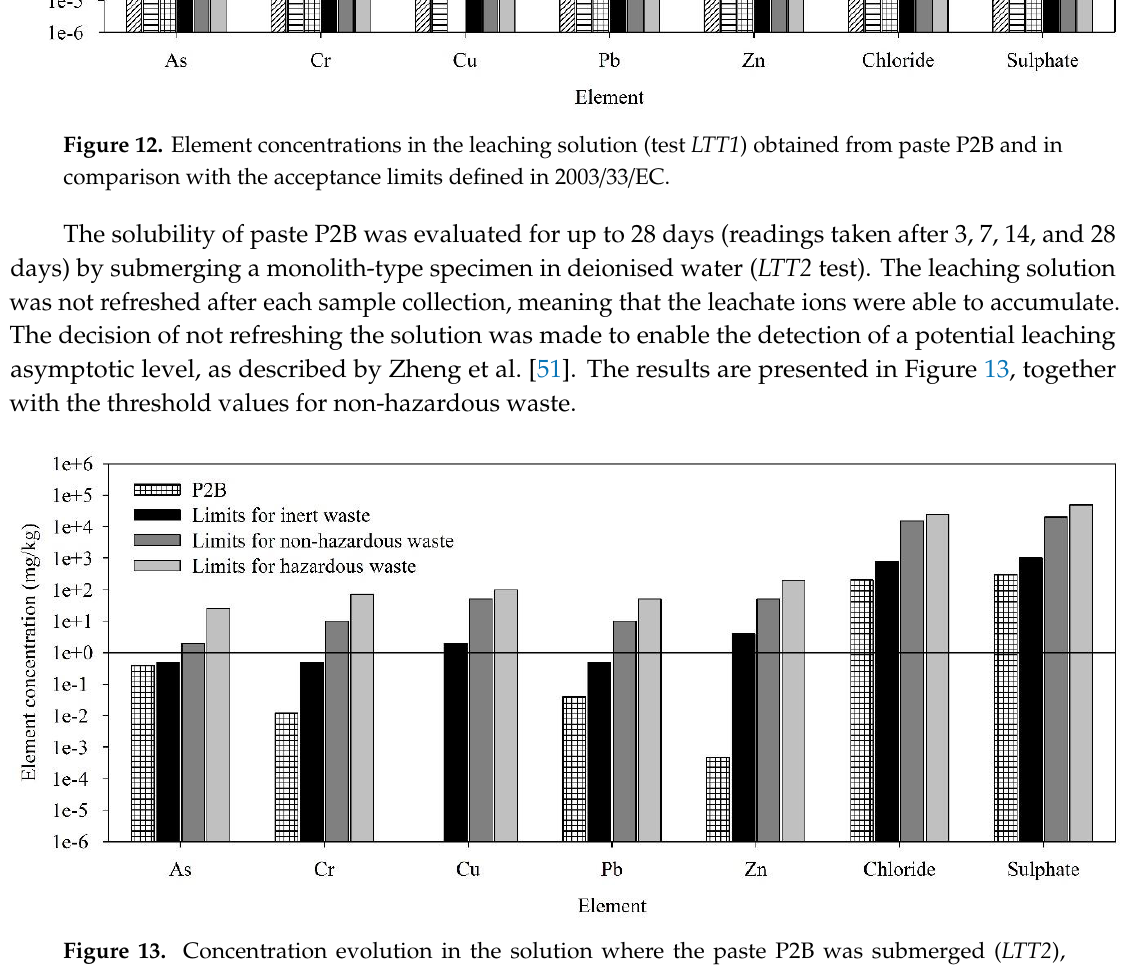
Table 6. pH of the solution at the time of sampling ( LTT2 ).